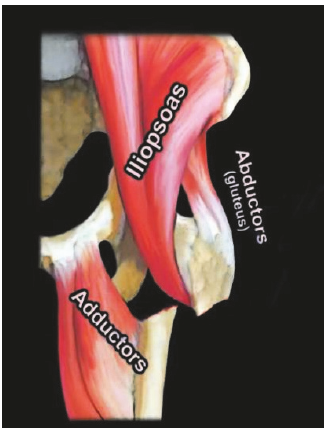
Figure 2: Subtrochantericfracturedeformity: The typical deformity of the subtrochanteric femur fracture is one of external rotation and abduction of the proximal segment and adduction of the distal